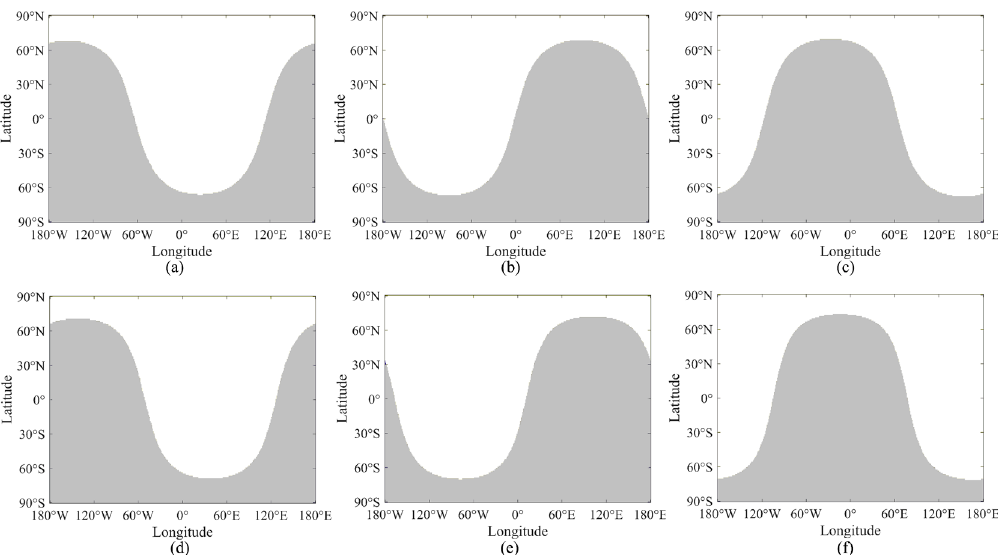
Figure 4. Global observation coverage from (0°,0°) on the lunar surface at ( a ) 00:00; ( b ) 08:00; ( c ) 16:00 UTC on 1 January; ( d ) 00:00; ( e ) 08:00; ( f ) 16:00 UTC on 2 January 2021. The light part means that these regions are visible for a Moon-based sensor, which changes with the positions of nadir point; the dark part represents the opposite.